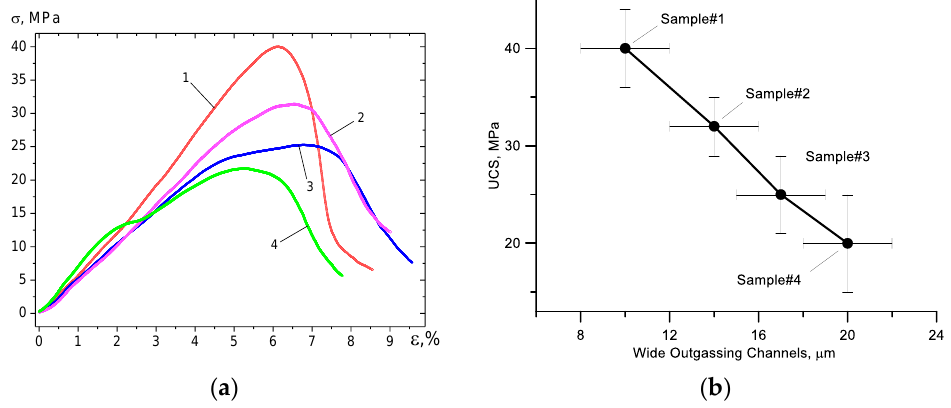
Figure 3. The monotonic compression “σ - ε” curves ( a ): 1 — Sample #1; 2 — Sample #2; 3 — Sample #3; 4 — Sample #4. UCS vs. wide pore channels curve ( b